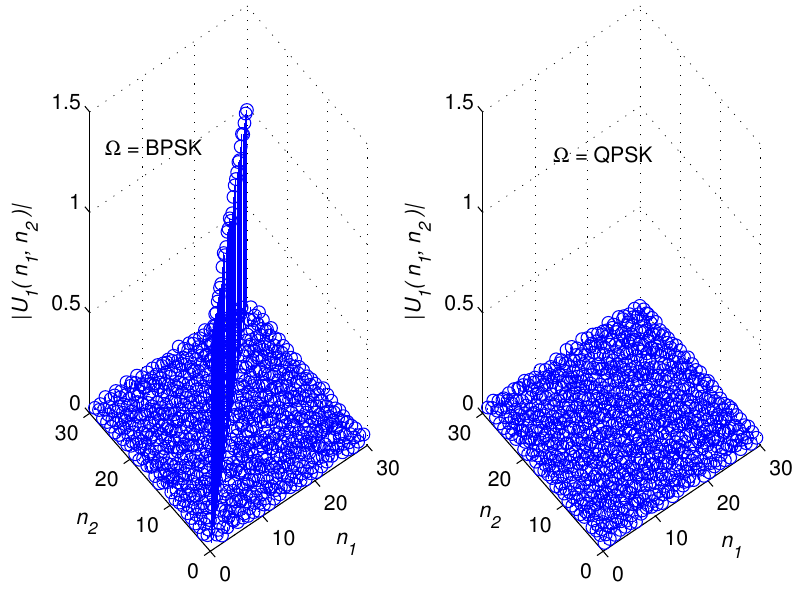
Figure 2. The magnitude of the first correlation function at the modulation forms of BPSK and QPSK.